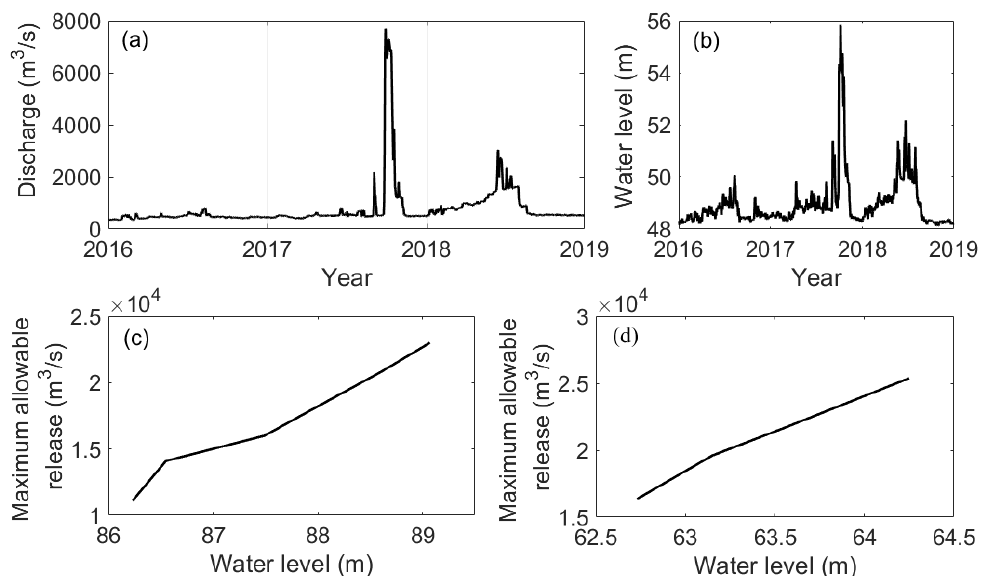
Figure 2. Flow regimes of the case study river. ( a ) Daily discharge at Huangjiagang station from 2016 to 2018. ( b ) Daily mean water level at Yicheng station from 2016 to 2018. ( c ) Maximum allowable release-water level relationship applied for Wangbuzhou water control project. ( d ) Maximum allowable release-water level relationship applied for Cuijiaying water control project.